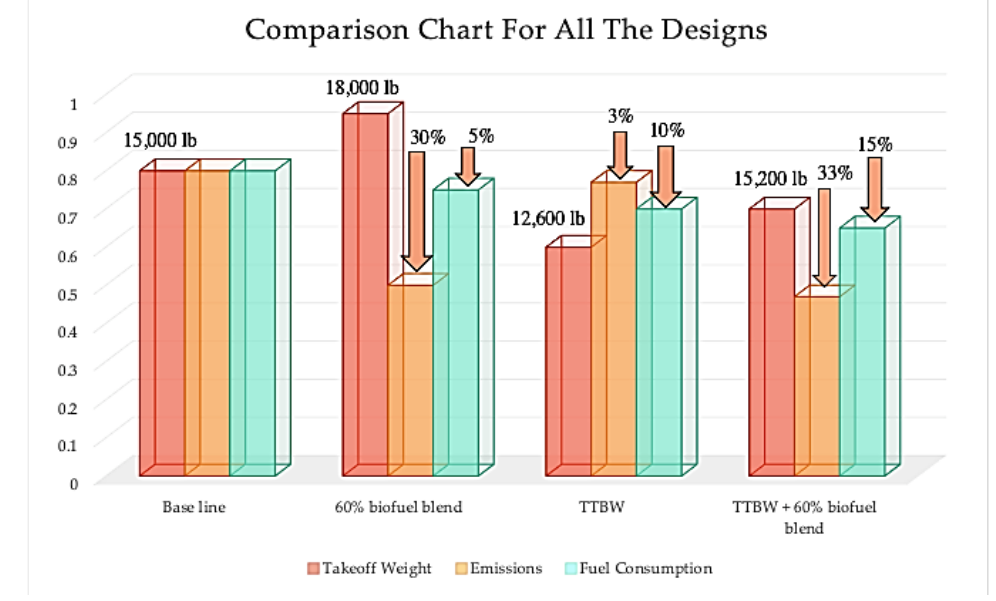
Figure 11. Comparison chart between the four proposed designs with respect to net weight and emissions.